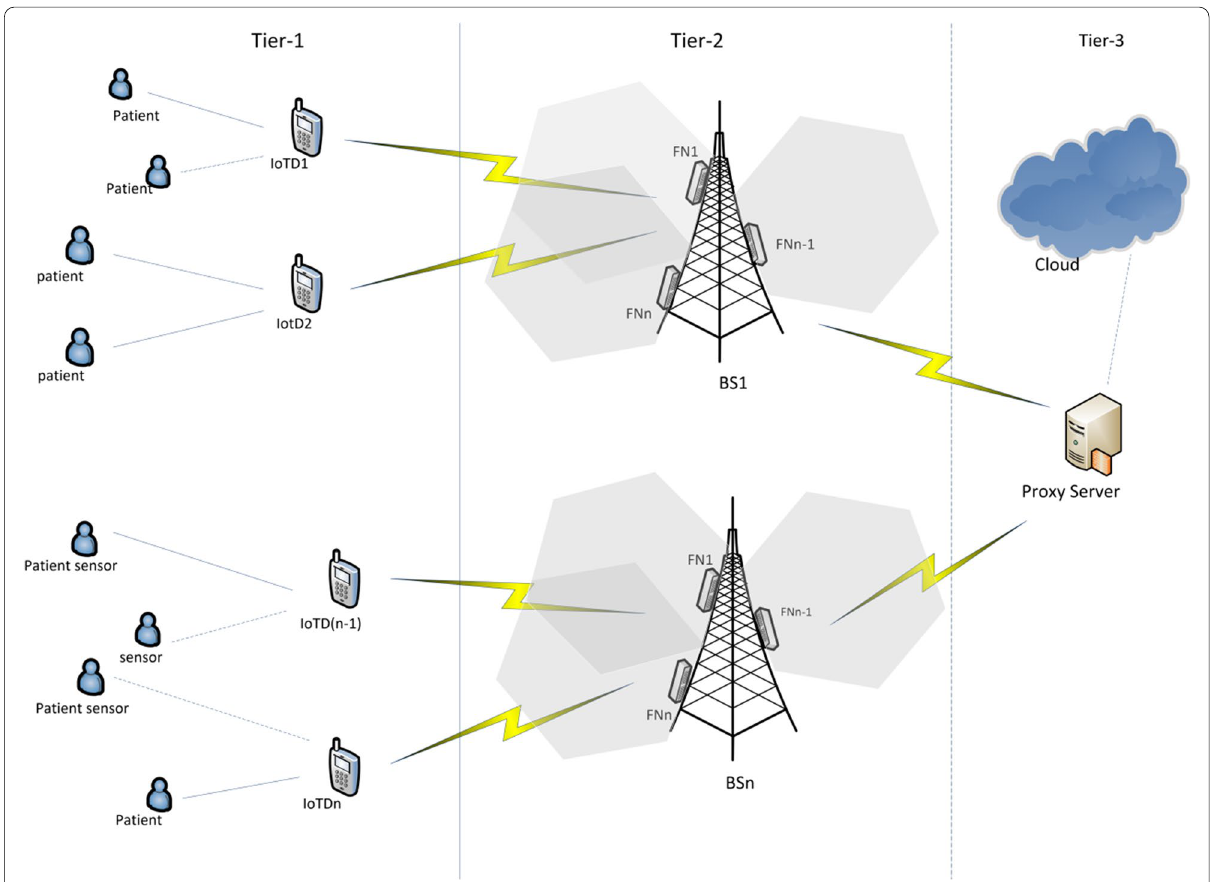
Fig. 1 General schema of the proposed